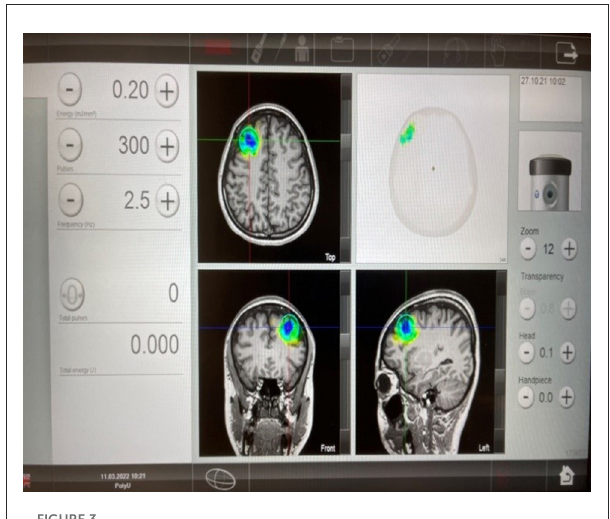
FIGURE3 Transcranial pulse stimulation (TPS) (STORZ MEDICAL) post-intervention images.